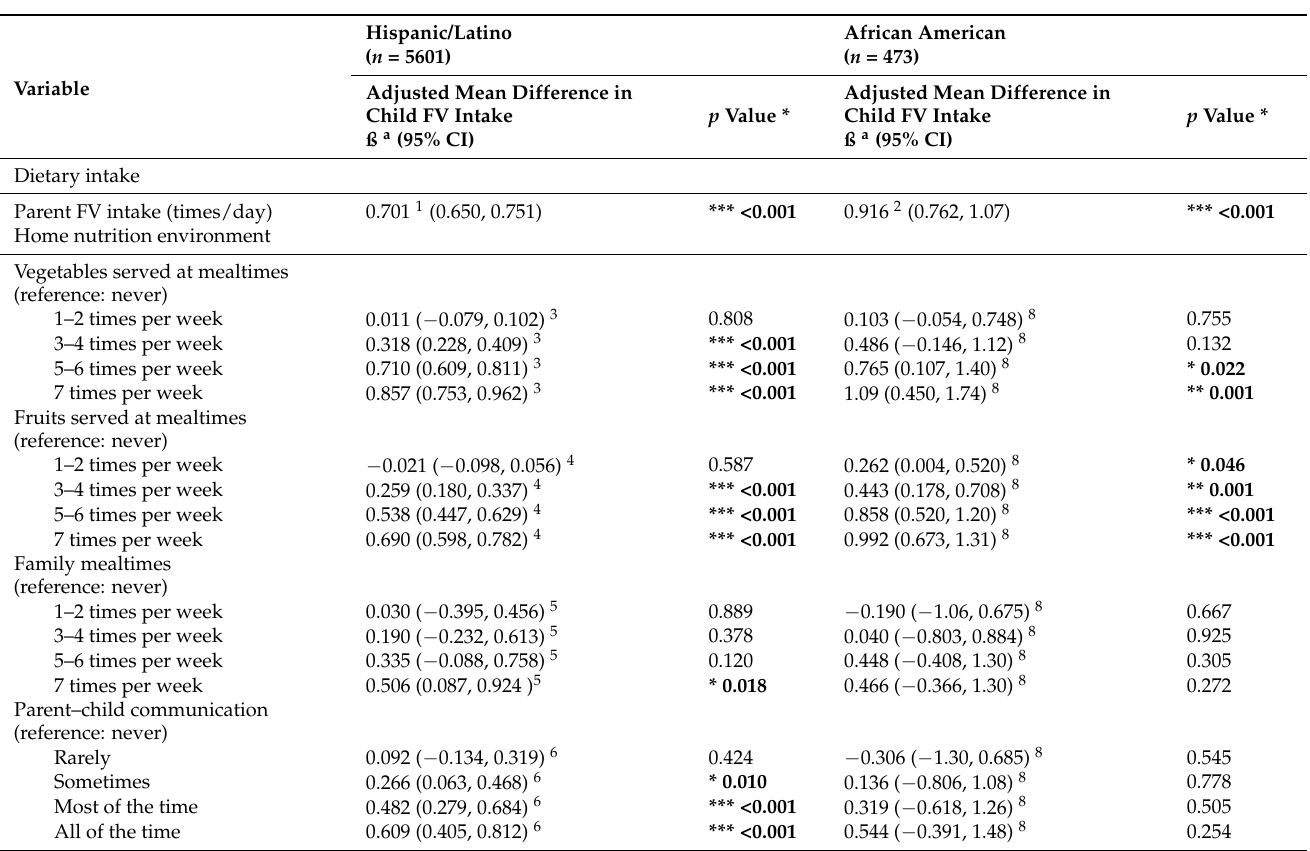
Table 3. Associations Between Parent Fruit and Vegetable (FV) Intake, Home Nutrition Environment and Child FV Intake Stratified by